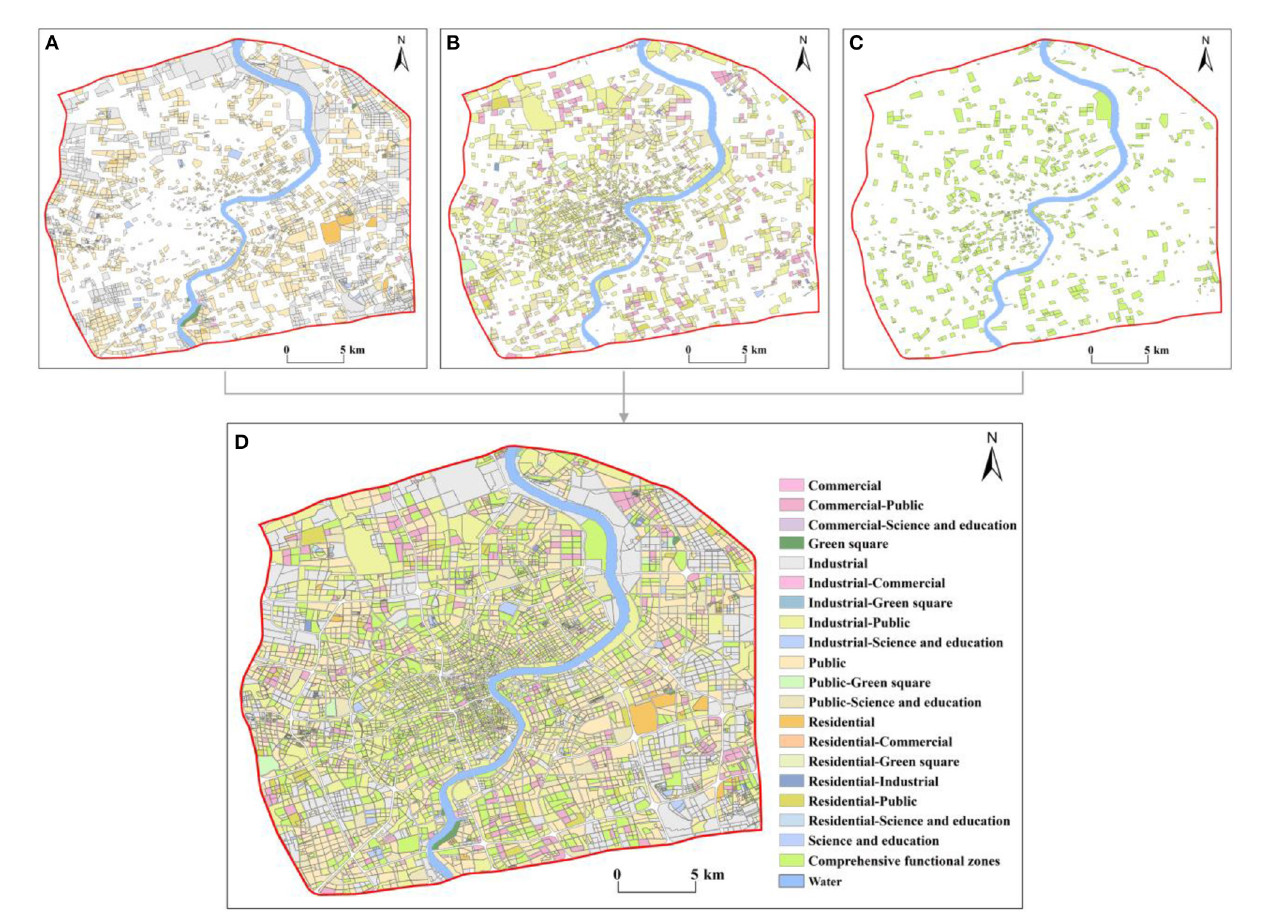
FIGURE2 Classification of urban functional zones in central Shanghai (A) single-type functional zones, (B) two-type mixed functional zones, (C) comprehensive functional zones, and (D) all functional zones within central Shanghai.